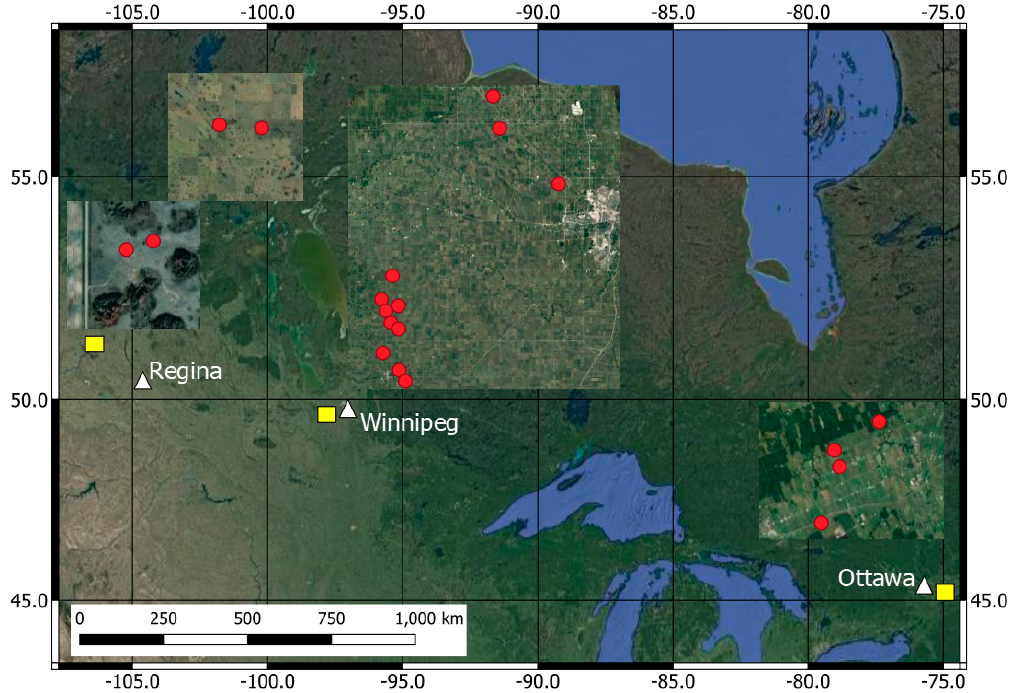
Figure 1. Location of the experimental sites (yellow squares) with insets showing the RISMA stations (red circles).